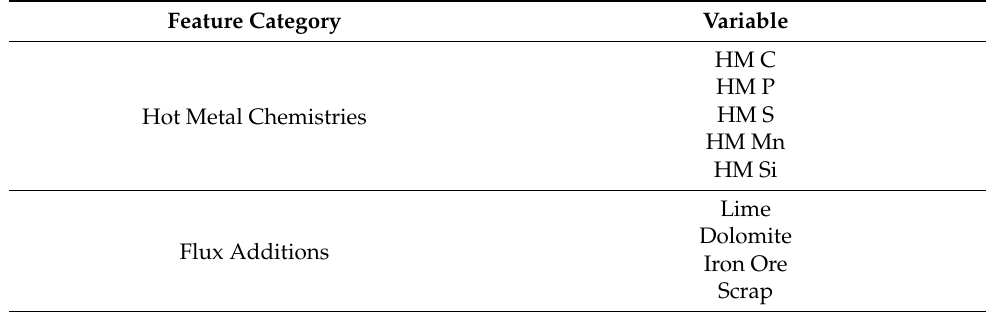
Table 2. User-specified inputs used for multiple linear regression to predict slag